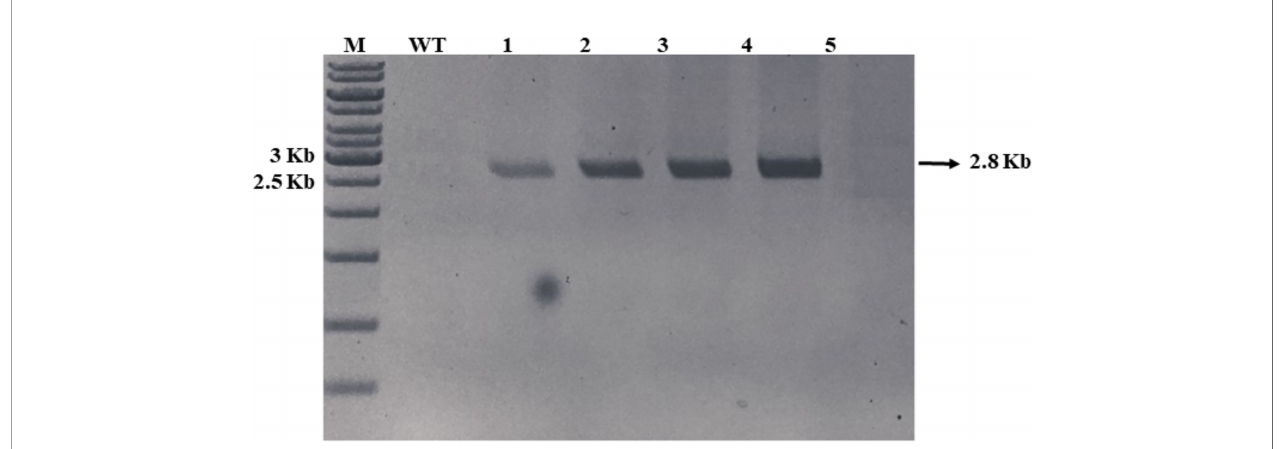
FIGURE 3 | PCR con fi rmation of chloroplast-transformed Chlorella vulgaris with pCMCC:bFGF. M, DNA ladder; WT, wild-type C. vulgaris DNA; lane 1, SM-L colony; lane 2, SM-NL colony; lane 3, S-L colony 1; lane 4, S-L colony 2; lane 5, negative reaction control. The 2.8-kb amplicon is indicated by an